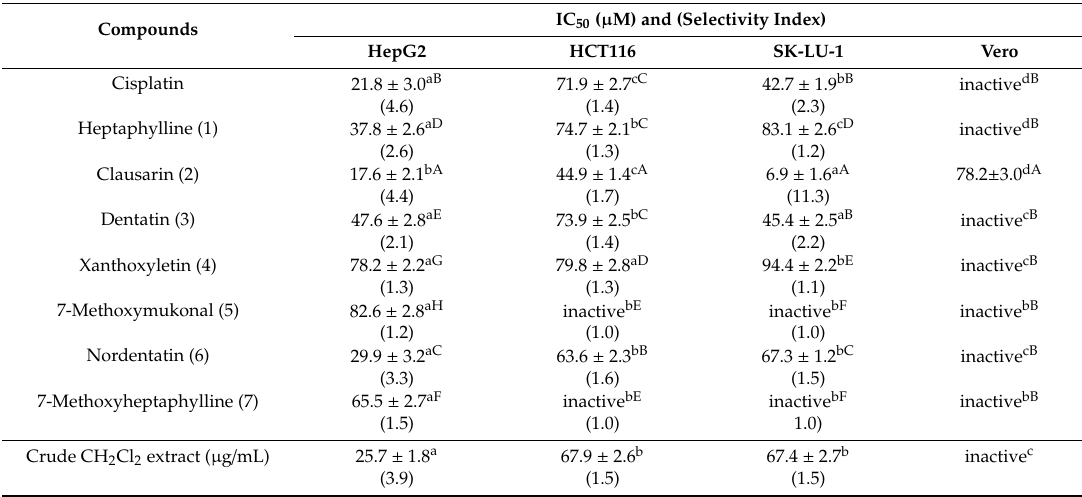
Table 2. Cytotoxicity and selectivity index of isolated compounds and CH 2 Cl 2 crude extract from C. harmandiana